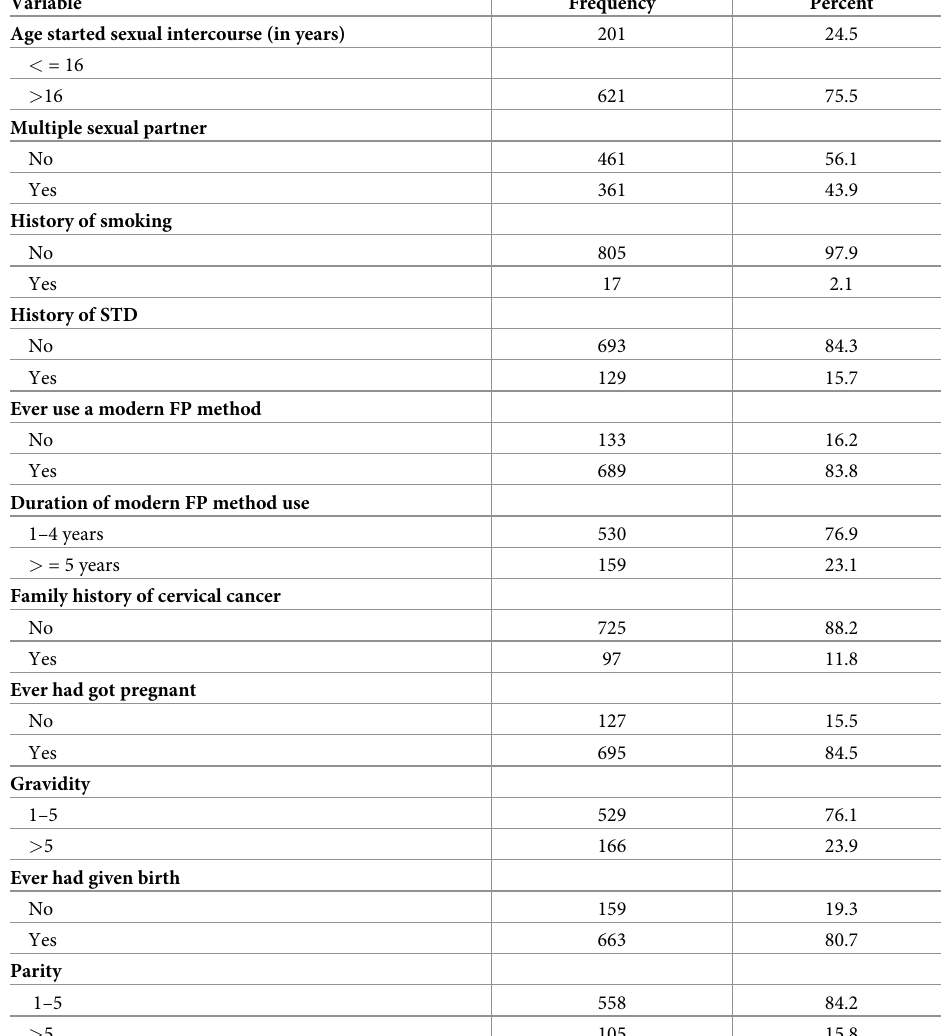
Table 2. Reproductive characteristics of women (n = 822) age 30–49 in Debremarkos town, Northwest Ethiopia,